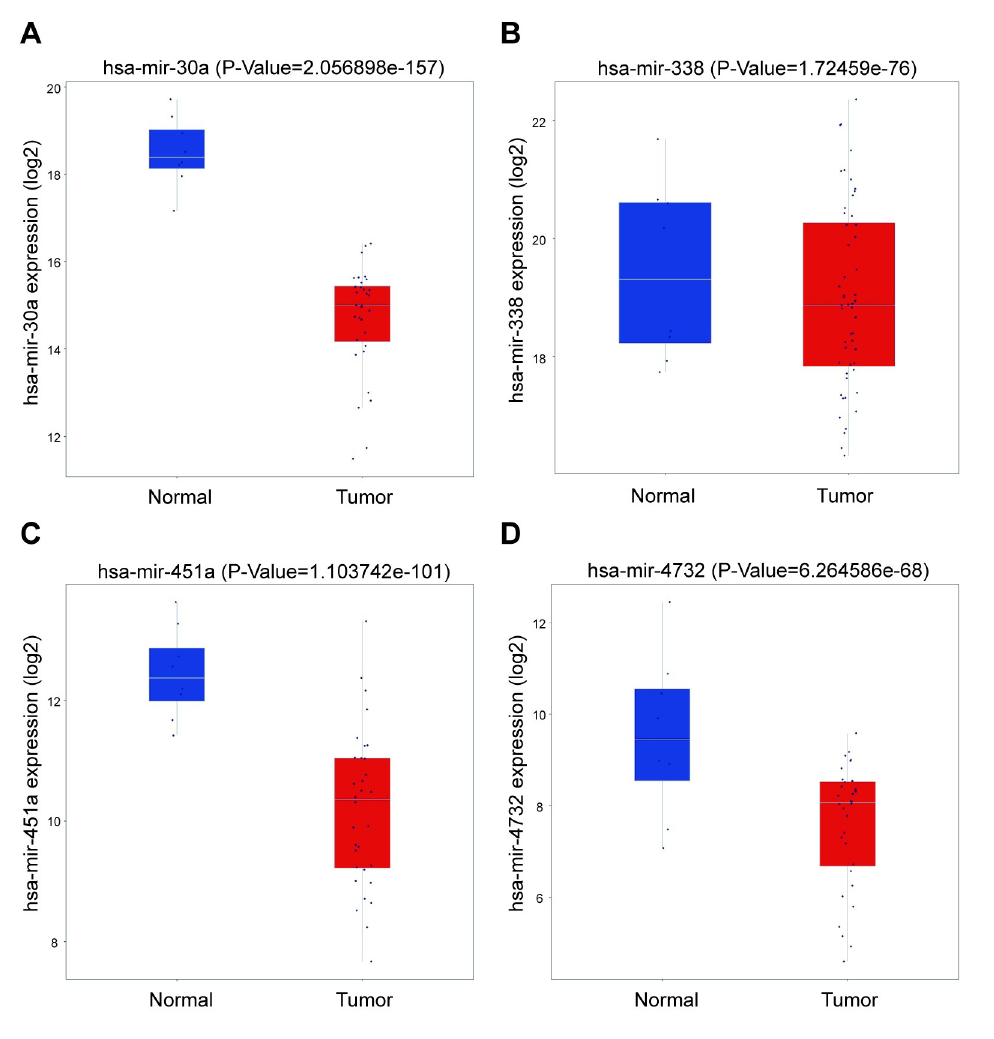
Fig 3. MiRNA expression in boxplots. A: Boxplot of hsa-mir-30a. B: Boxplot of hsa-mir-338. C: Boxplot of hsa-mir-451a. D: Boxplot of hsa-mir-4732. The abscissa represents the sample, Normal: Paracancerous tissue, Tumor: NSCLC tissue. The ordinate represents the expression level of miRNA, p <